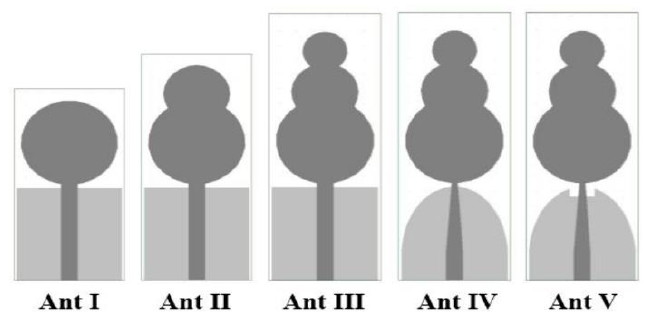
Figure 3. Evolution of antenna linked with port 1.